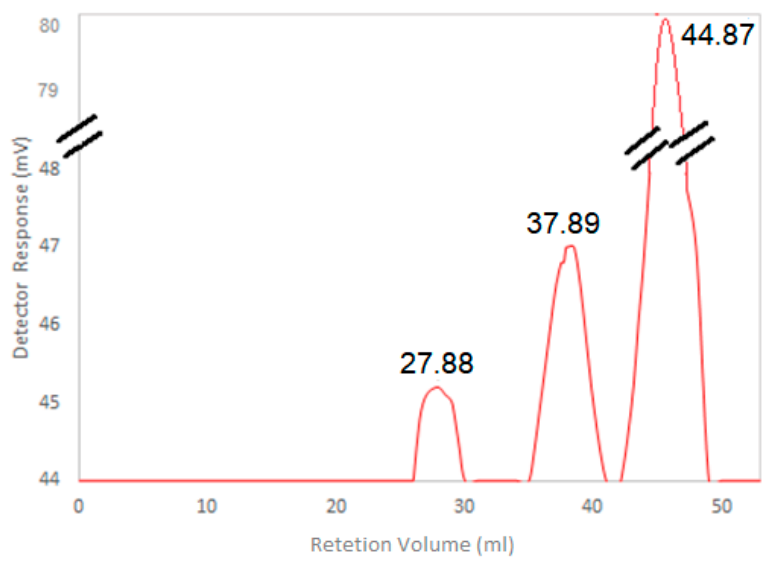
Figure 4. Gel Permeation Chromatography (GPC) analysis of the Hyaluronic Acid (HA) purified from BAP strain after growth in bioreactor.